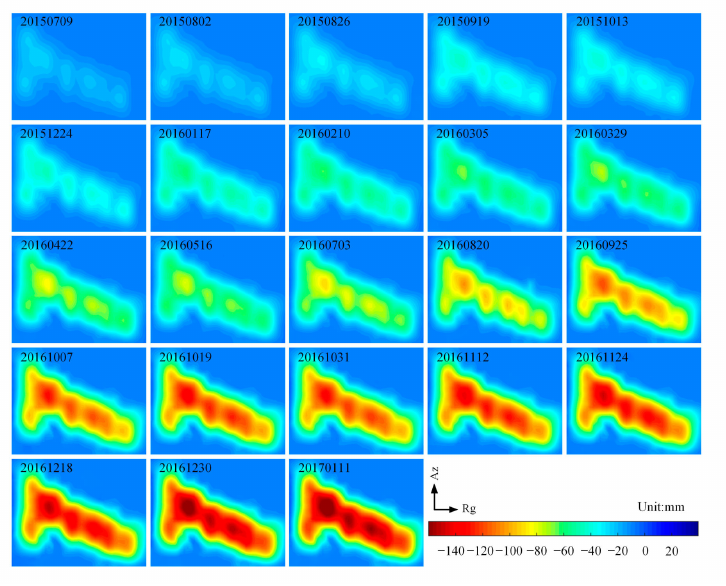
Figure 12. Derived deformation sequences based on InSAR-CTPIM (reference date: 15 June 2015).